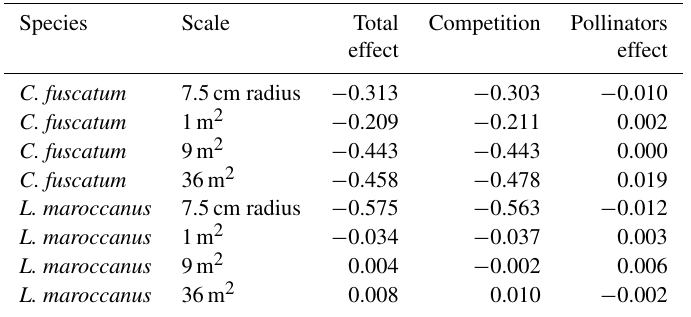
Table A5. Decomposition of the direct and indirect effects across the different scales in the species that are scale dependent ( C. fuscatum and L. maroccanus ). The standardized total effects are